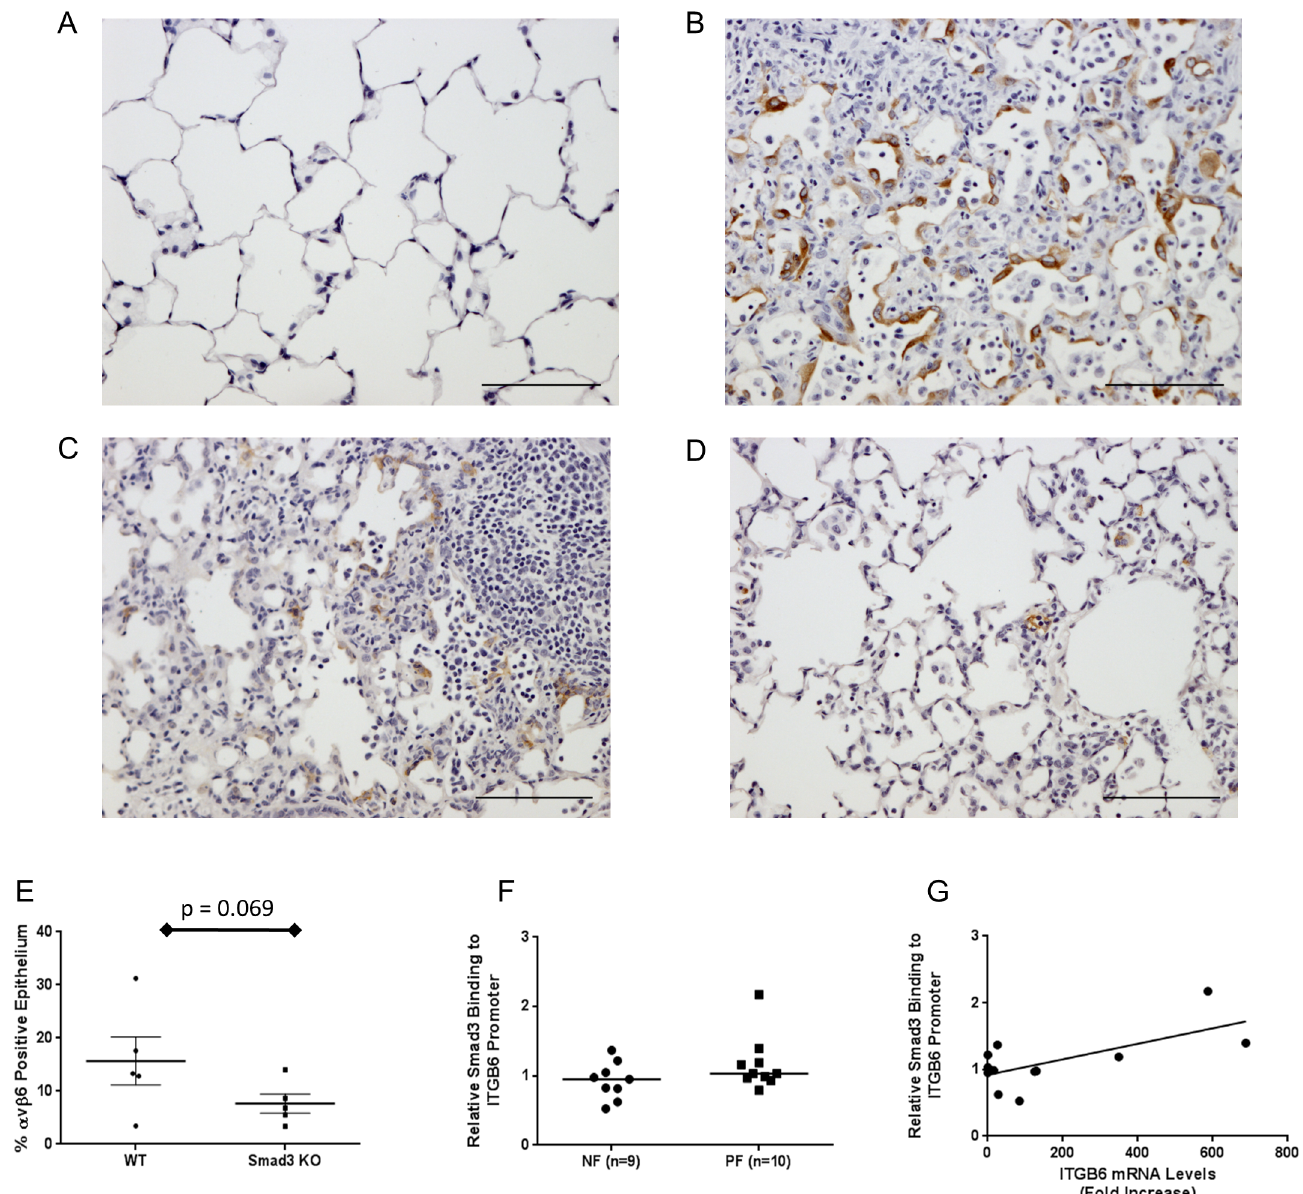
Fig 6. A. Rats were treated with a control adenovirus for 21 days and lung tissue was stained by immunohistochemistry for α v β 6 integrins. Figure is representative of n = 3 animals. B . Rats were treated with a TGF β 1 over-expression adenovirus for 21 days and lung tissue was stained by immunohistochemistry for α v β 6 integrins. Figure is representative of n = 3 animals. C . Smad3 +/+ control animals were treated with a TGF β 1 over- expression adenovirus for 21 days and lung tissue was stained by immunohistochemistry for α v β 6 integrins. Figure is representative of n = 5 animals D . Smad3 -/- control animals were treated with a TGF β 1 over-expression adenovirus for 21 days and lung tissue was stained by immunohistochemistry for α v β 6 integrins. Figure is representative of n = 4 animals E . α v β 6 immunohistochemistry described in Fig 5C and 5D was quantified using in a blind manner using a semi-quantitative, user-dependent method. Data are expressed as % of α v β 6 positive alveolar epithelium. Bars show mean ± SD F . Human lung tissue from pulmonary fibrosis donors (n = 10) and non-fibrotic controls (n = 9) was subjected to ChIP analysis to determine basal levels of Smad3 binding to the endogenous ITGB6 promoter in the region -936 to -755 from the transcription start site. Data are expressed as relative binding to the ITGB6 promoter (relative to IgG levels in each donor sample) and the median shown. Relative binding of 1 or below demonstrates no binding of Smad3 above IgG control levels. G . Relative binding of Smad3 measured in Fig 5F was correlated with measured levels of ITGB6 mRNA in each donor sample using linear regression analysis. R 2 = 0.44, p = 0.019.